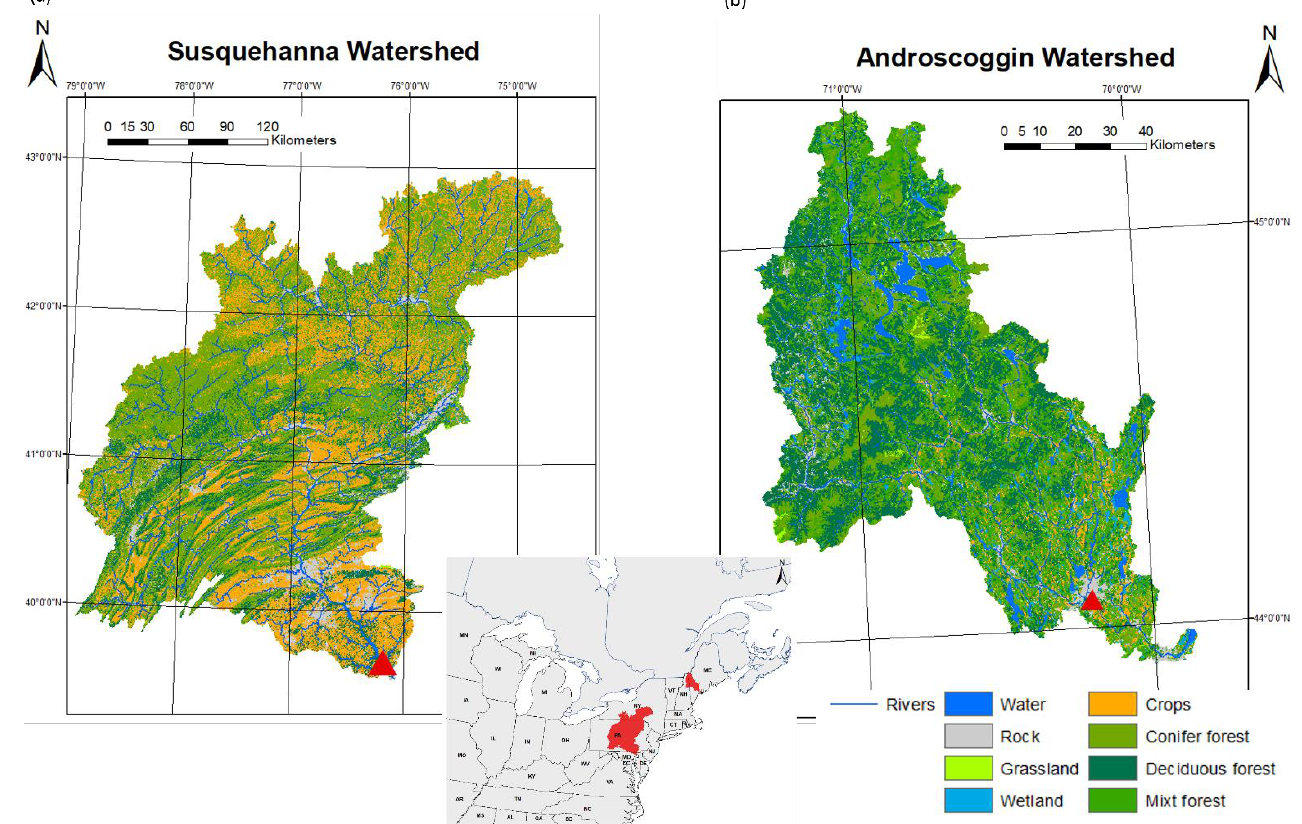
Figure 1. Land cover of Susquehanna ( a ) and Androscoggin ( b ) watersheds. Red triangles indicate the location of the United States Geological Survey (USGS) streamflow stations used (reference number 1,578,310 and 1,059,000 for the Susquehanna and the Androscoggin watersheds respec- tively).